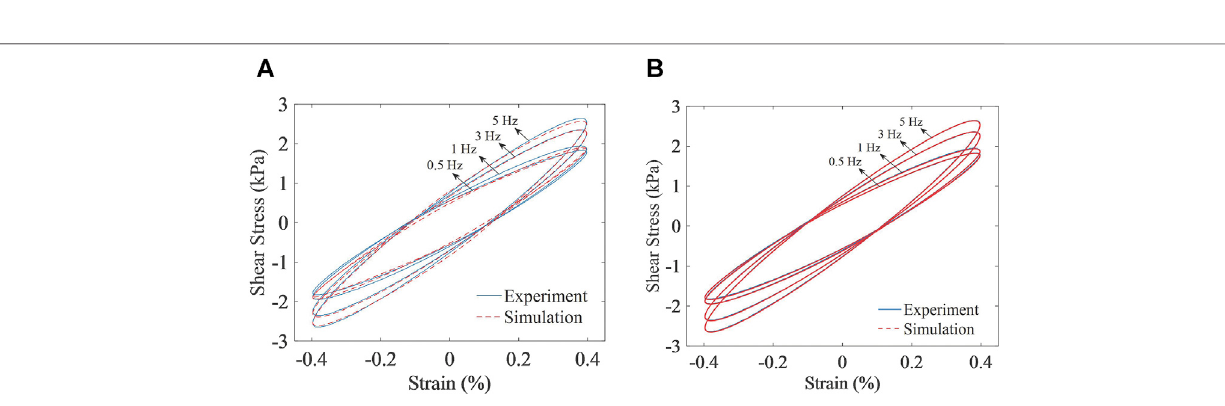
Frontiers in Materials |